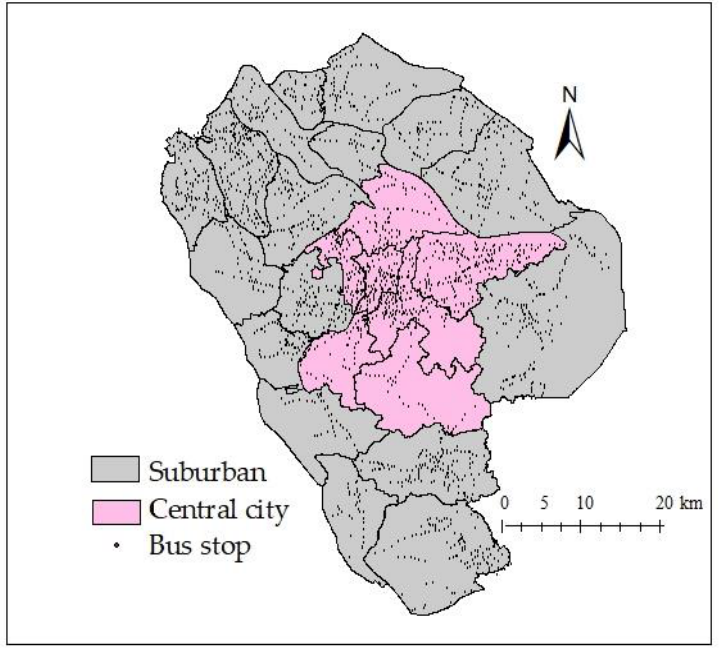
Figure 1. Study area.